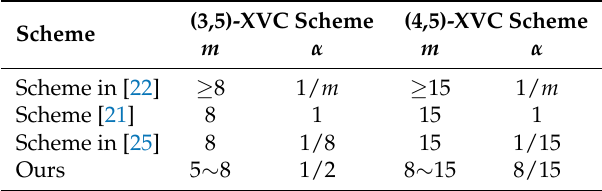
Table 3. The pixel expansion and contrast